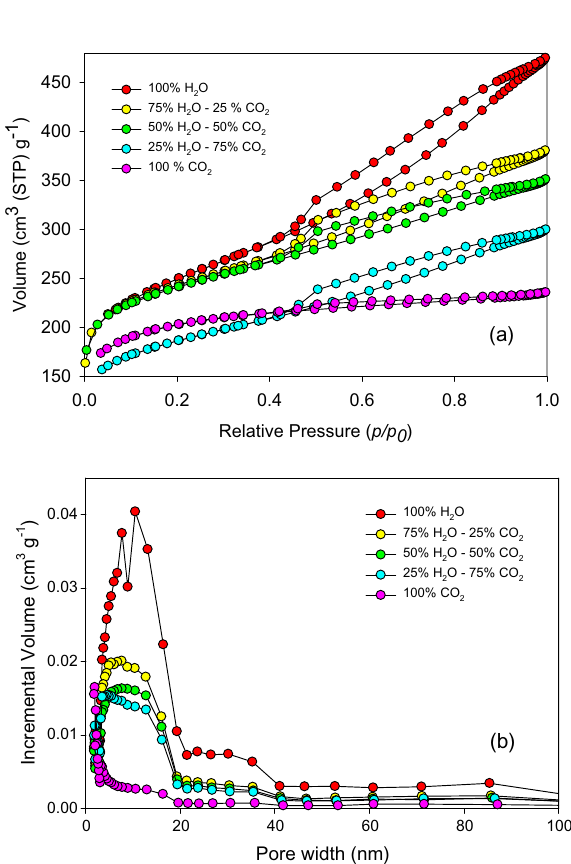
Figure 4. ( a ) Adsorption/desorption isotherms and ( b ) pore-size distribution of D. linearis